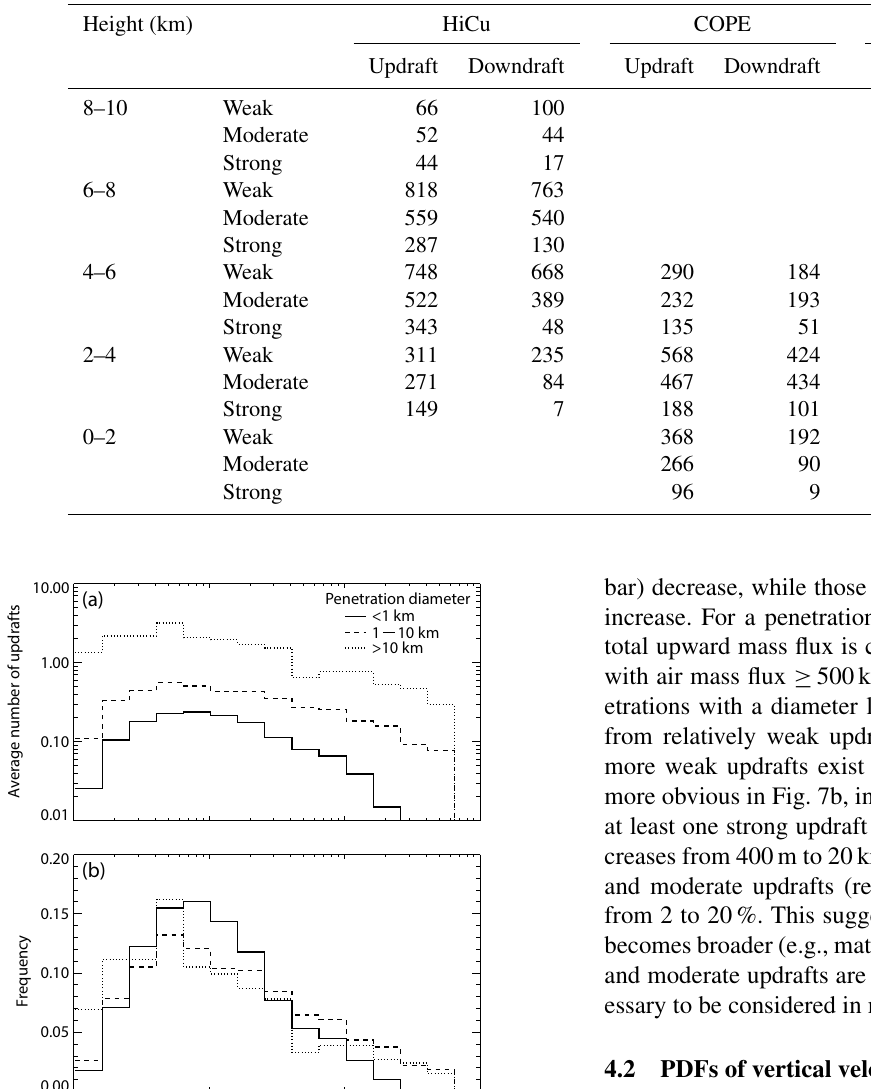
Table 2. Number of updrafts and downdrafts sampled at 0–2, 2–4, 4–6, 6–8, and 8–10km in HiCu, COPE, and ICE-T. Three numbers are given for the updraft and downdraft at each level, according to the three different definitions: weak, moderate, and strong.